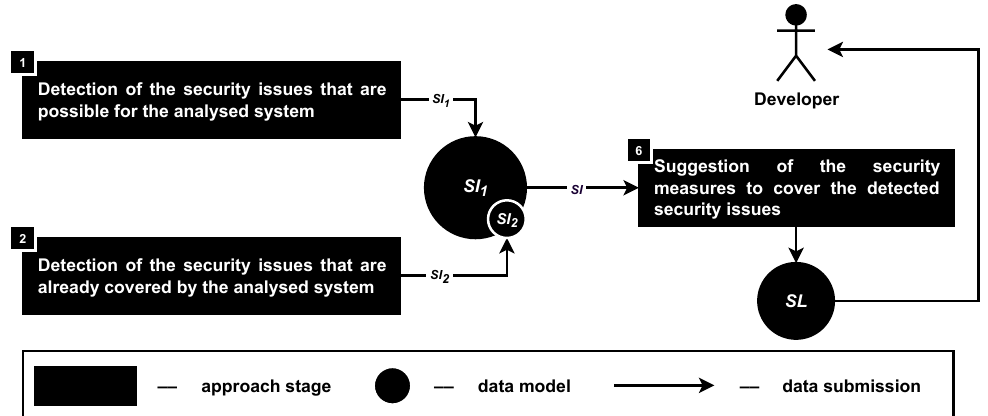
Figure 9. Stage 6—Suggestion of the security measures.